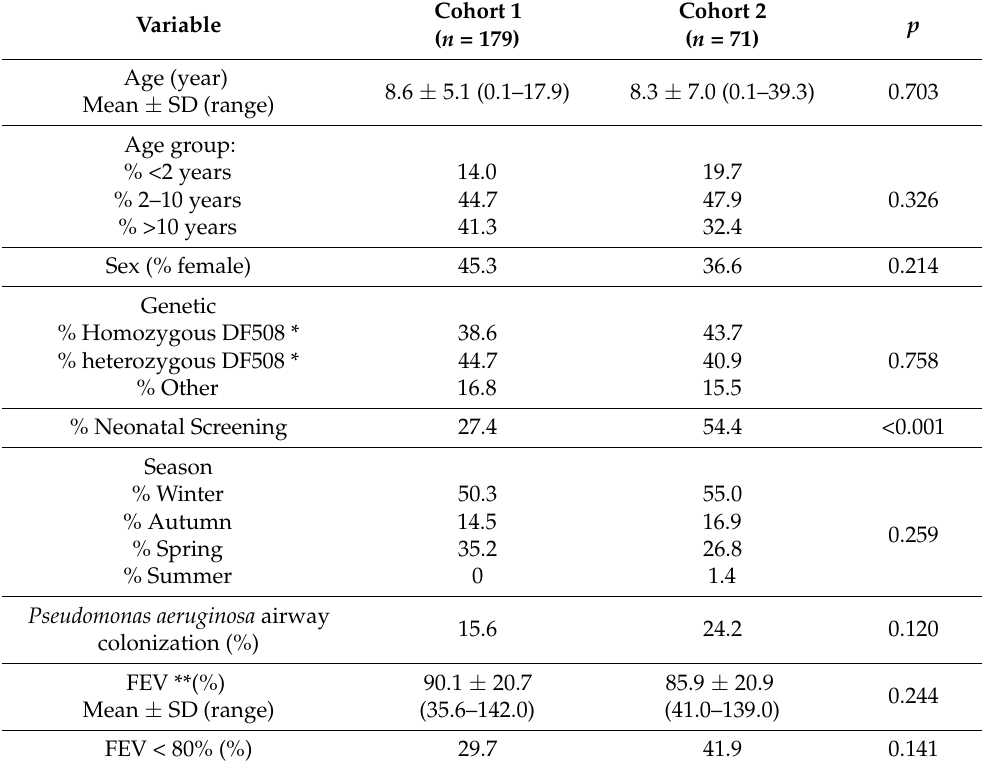
Table 2. Main clinical features of both groups.